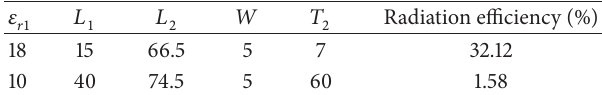
Table 2: Design parameters (in mm) of embedded loop antennas with dielectric constants 18 and 10 at 403